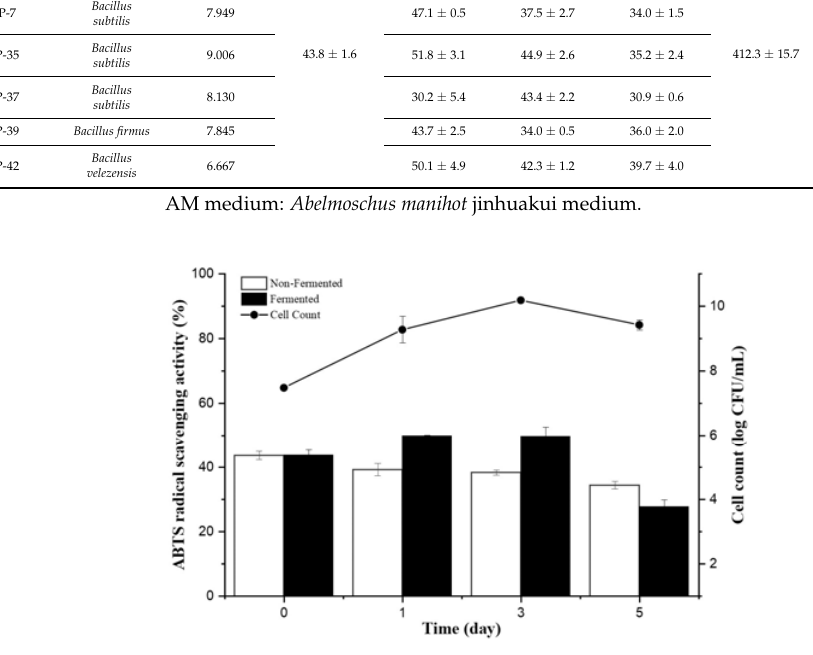
Figure 3. Change in bacterial viability and antioxidant activity of Abelmoschus manihot fermented with Bacillus licheniformis CP6 during fermentation. Table 1. Antioxidant activity of six strains that showed growth of 1% Abelmoschus manihot medium.